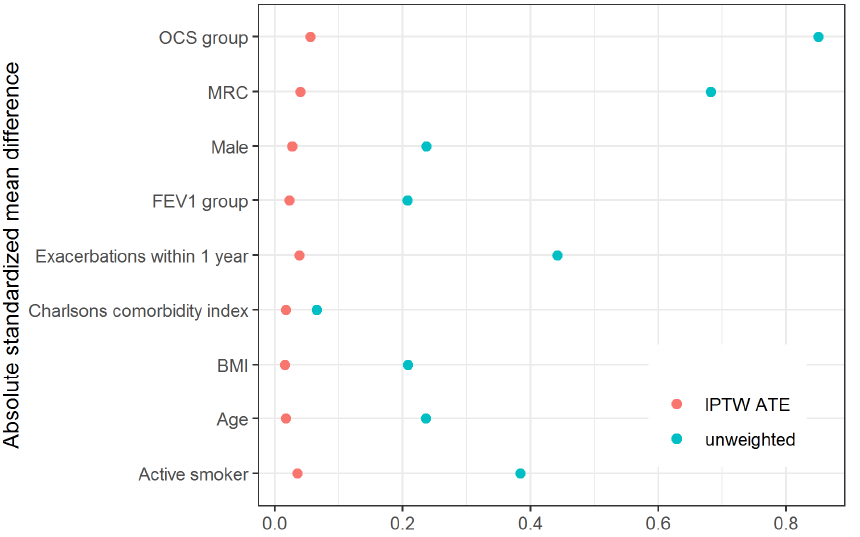
Figure A2. Maximum pairwise absolute standardized mean difference (SMD) before and after inverse probability of treatment (IPTW) weighting. The values shown are the maximum SMD among all pairwise comparisons between the 4 groups. Charlson comorbidity index is excluding HIV. Abbreviations: ATE: Average treatment effect in the population, BMI: Body mass index. FEV1: Forced